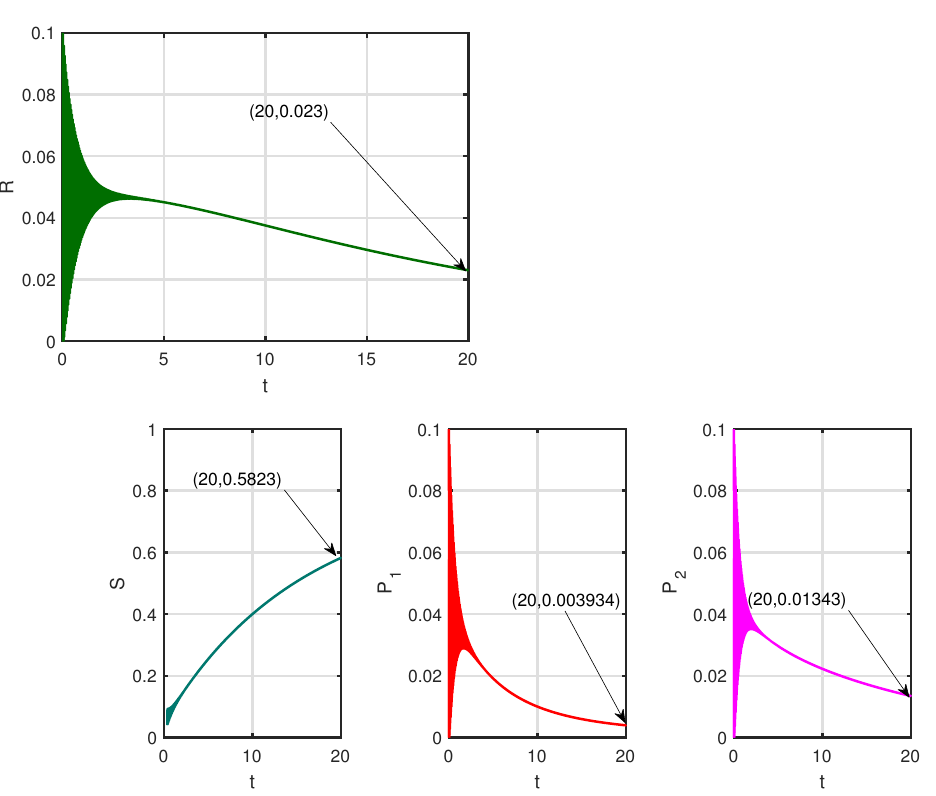
Figure 14. Time series of state variables of system (26) for Table 6 when ε = 0.95 and η =